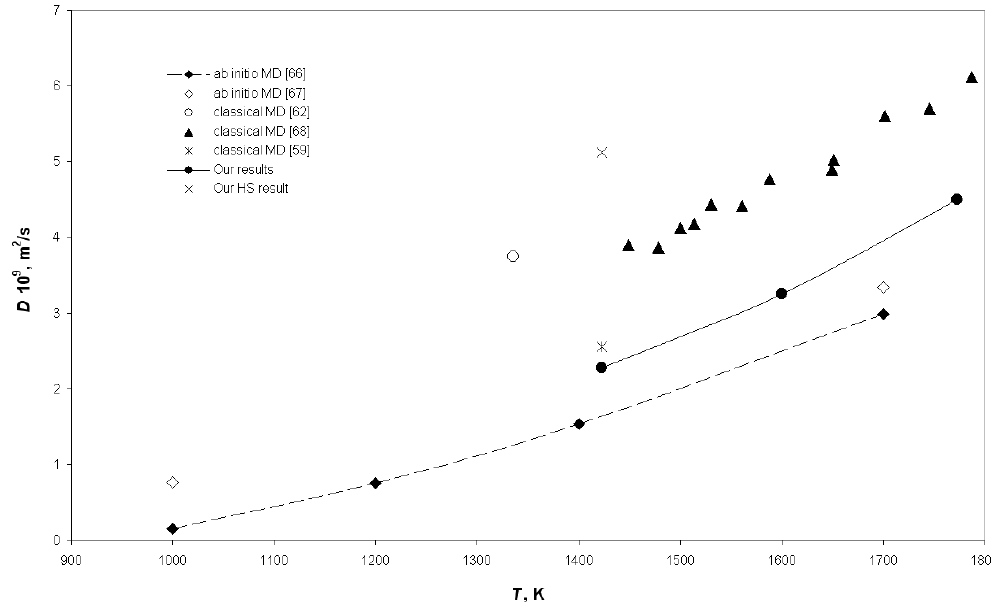
Figure 3. Self-di ff usion coe ffi cient of liquid Figure 3. Self-diffusion coefficient of liquid Au. Figure 3. Self-diffusion coefficient of liquid Au.